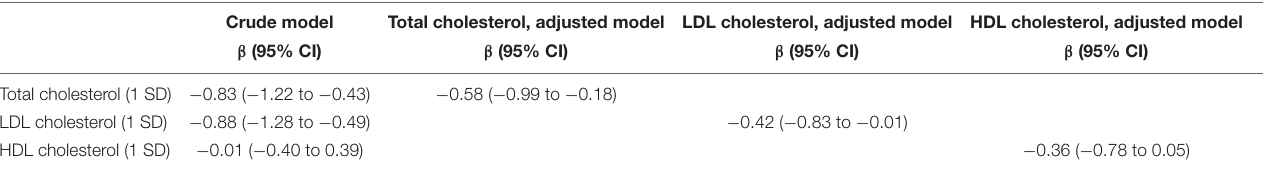
TABLE 4 | The associations between serum lipid levels and